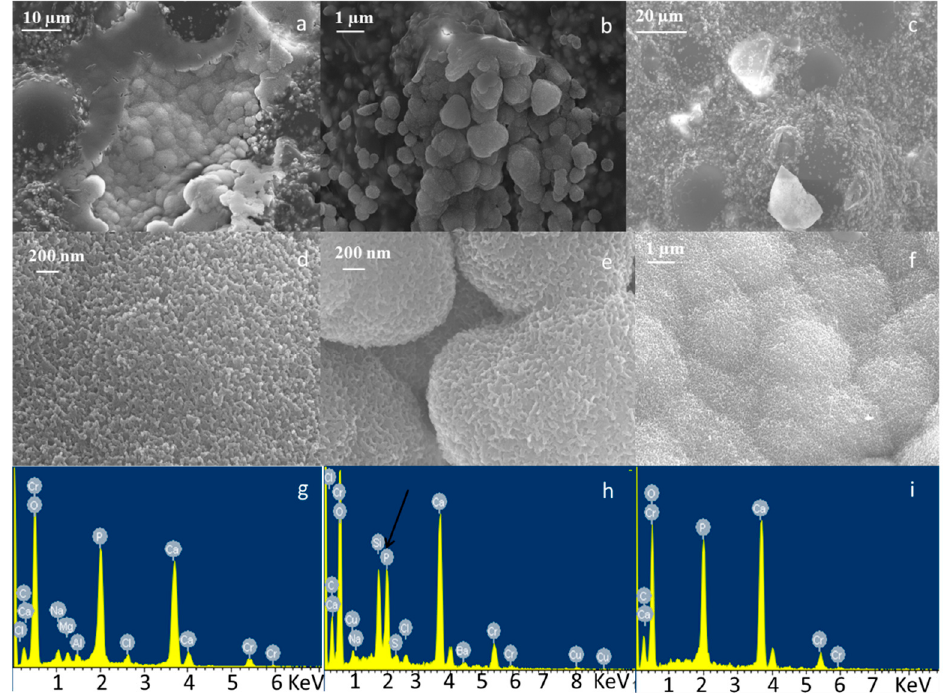
Figure 3. FESEM and EDS analysis of ( a , d , g ) CEMEX ® ISO-Cu, ( b , e , h ) CEMEX ® RX-Cu, and ( c , f , i ) CEMEX ® XL-Cu immersed in simulated body fluid (SBF) solution up to 7 days.